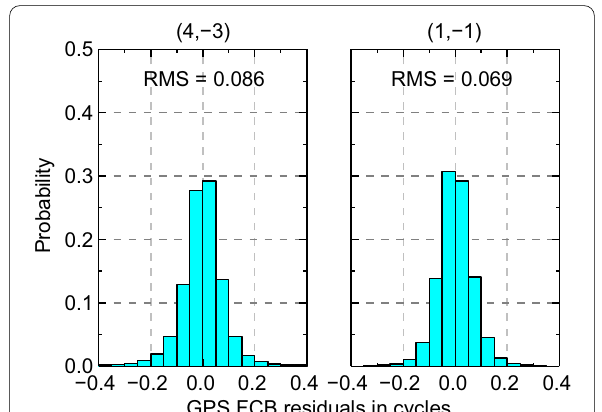
−0.4 −0.2 0.0 0.2 Fig. 3 Histogram of the GPS FCB residuals in the NL and WL linear combinations